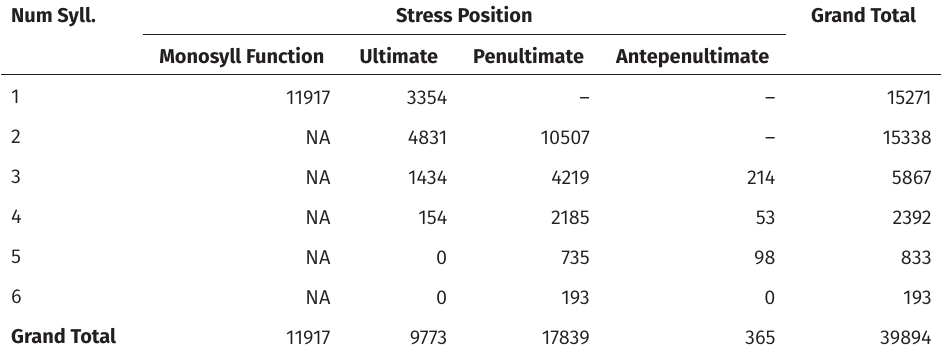
Table 2: Word tokens in the WPC as a function of the number of syllables and stress locus. Num